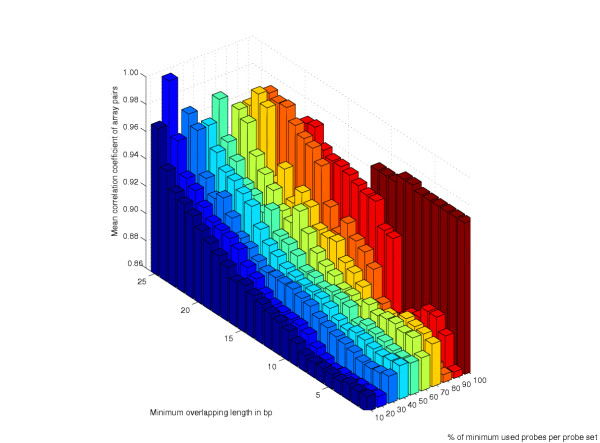
Improvement in the correlation coefficients of array pairs for the same biopsy according to the minimum overlapping length (1 ~ 25 bp) and the percentage of used probes per probe set (10 ~ 100%). The correlation coefficients are the average of 14 arrays pairs. The probes are selected based on sequence overlap, and the probe sets with a sufficient number of such probes are used to recalculate the expression profiles. The correlation is enhanced with increasing number of minimum overlap length and, to a lesser extent, with increasing percentage of probes required for probe set.